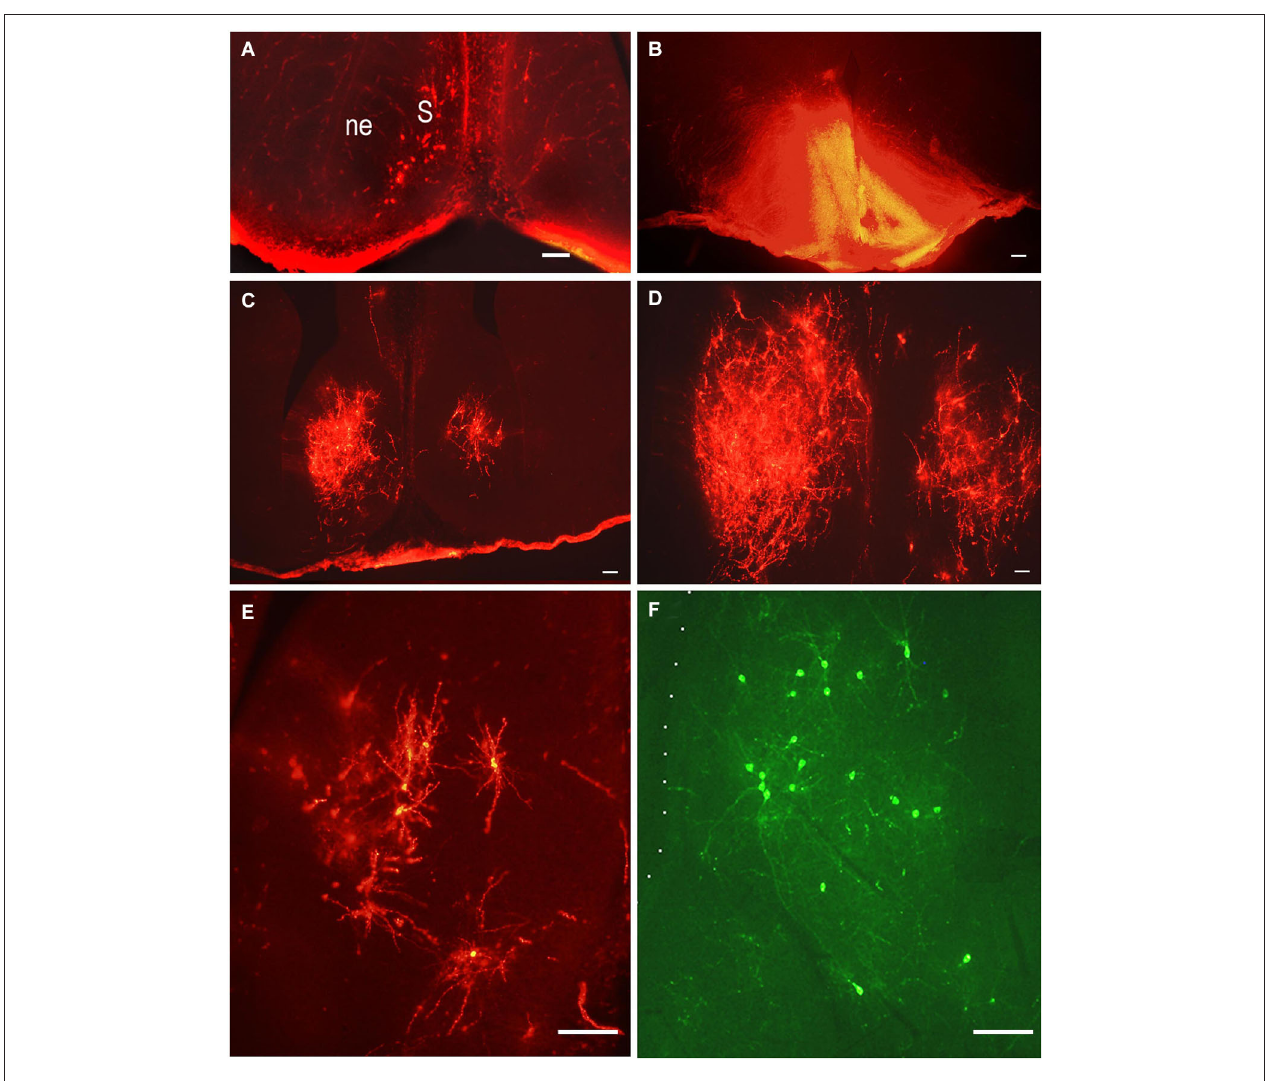
area; (C) and (D) E18, distribution of retrogradely labeled neurons in the lateral septal nuclei on the rostral and medial levels. (E) E18, DiI-labeled multipolar neurons in the lateral septum at larger magnification. (F) E.18, DiA-labeled multipolar neurons in the lateral septum. Scale bars =100 µ